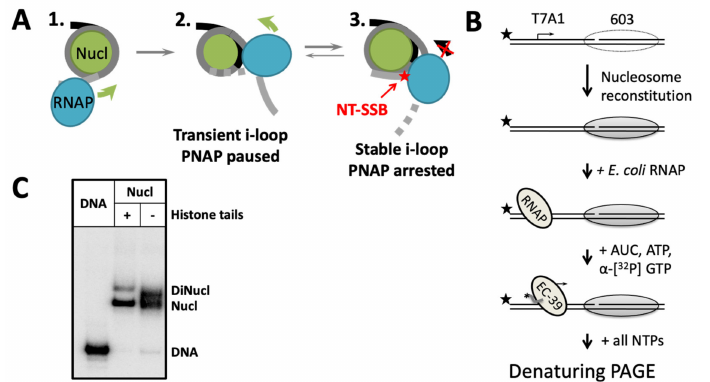
Figure 1. Experimental strategy for analysis of the effect of NT-SSBs on transcription through chromatin. ( A ) A model describing the effect of NT-SSBs on transcription through a nucleosome [27,29,30]. As RNAP encounters a nucleosome (intermediate 1), transient intranucleosomal i-loops can be formed (intermediate 2). An NT-SSB positioned behind the transcribing enzyme (shown by red star) greatly stabilizes the i-loop, inducing arrest of RNAP (intermediate 3) [30]. Direction of transcription is indicated by green and black arrows. ( B ) The 603 nucleosomes containing unique ssDNA gap ( − 12, − 11 or − 10) or break (+2) in the non-template strand are assembled on the DNA and transcribed for different time intervals in the presence of various concentrations of KCl. Pulse-labeled RNA (the label is shown by black asterisk) is separated by denaturing PAGE. Non-template DNA strand is 5’-labeled (shown by the black stars). Transcription start site is indicated by arrow. ( C ) An example of nucleosomes with ssDNA gap at the position − 11 bp in nucleosomal DNA assembled using histone octamers with or without histone tails. DNA was radioactively labeled at 5 (cid:48) -end. Analysis by non-denaturing